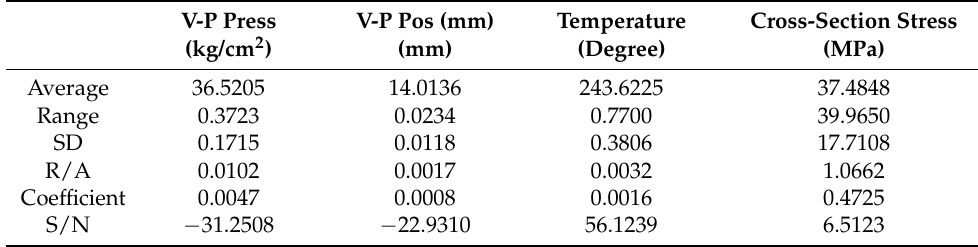
Table 5. VM and RPM control corresponding